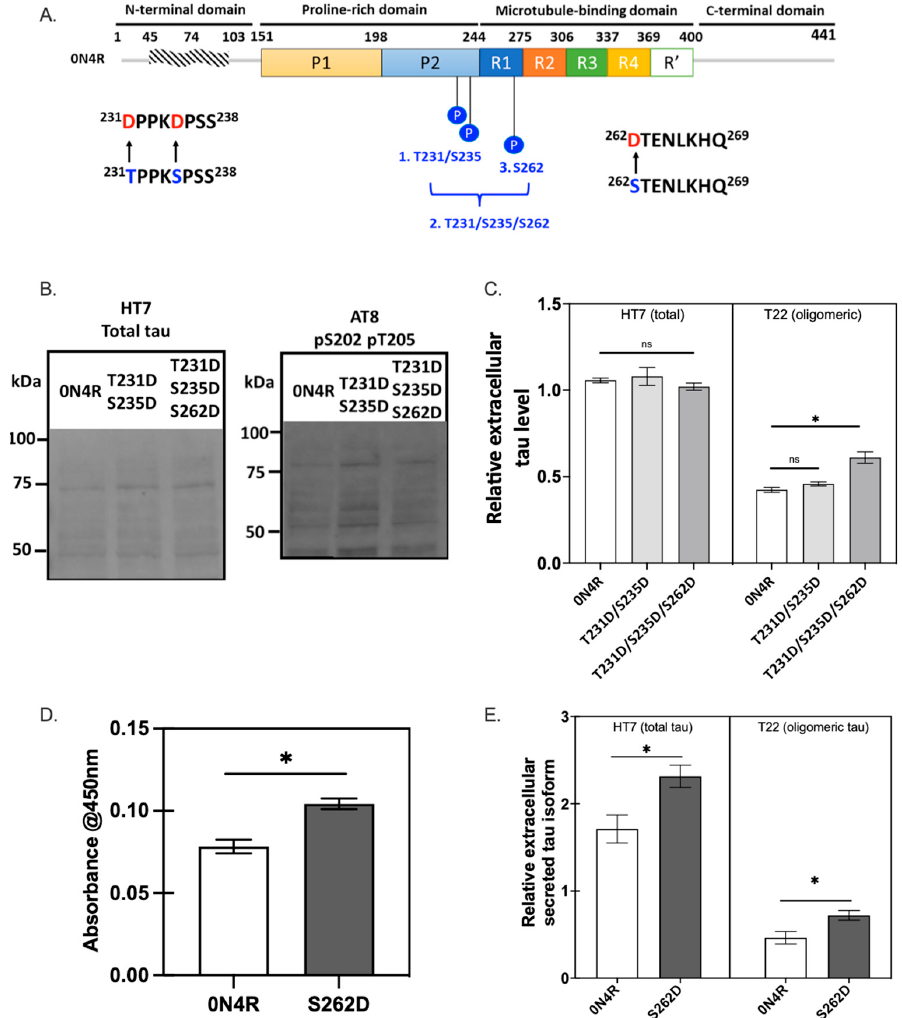
Figure 7. S262 phosphorylation increases tau secretion. ( A ) Schematic illustration of tau variants created via site-directed mutagenesis of wild type 0N4R construct by substituting serine at multiple phosphorylation sites (blue circles with “P” as indicated) into aspartic acid: (1) T231D/S235D; (2) T231D/S235D/S262D; (3) S262D. The residues are numbered in blue based on the full-length tau isoform, 2N4R, with regions of interest as noted by colored boxes. The amino acid sequences around these sites are also included using one letter abbreviation and the wild-type amino acid in blue, the change to aspartic indicated in red. P1 and P2 represent the proline-rich domains; R1–R4 and R’ indicated microtubule binding repeat domains. ( B ) Cell lysates from SH-SY5Y cells transfected with 0N4R tau wild-type (0N4R), T231D/S235D, or T231D/S235D/S262D, were analyzed by immunoblotting against the total tau antibody, HT7 and the phosphorylated tau antibody, AT8. ( C ) ELISA assay was used to measure the total tau, HT7, and oligomeric tau, T22, present in the conditioned medium collected from these three groups, three days following transient transfection in SH-SY5Y cells. 0N4R tau (0N4R; unshaded), T231D/S235D (light gray), or T231D/S235D/S262D (dark gray) (* represents p < 0.05 for 0N4R compared with S262D tau; n = 3) ( D ). Oligomeric tau was measured by sandwich ELISA using T22 and HT7 from the cell lysates of SH-SY5Y cells transfected with wild type 0N4R tau (unshaded) or the S262D variant (dark gray) (* represents p < 0.05 for 0N4R compared with S262D tau; n = 3). ( E ) The total tau and oligomeric tau in the conditioned medium were measured by indirect ELISA using HT7 or T22 to investigate the effects of Ser262 phosphorylation alone on tau secretion. 0N4R tau (unshaded); S262D variant (dark gray) (* represents p < 0.05 for 0N4R compared with S262D; n = 3; ns = not